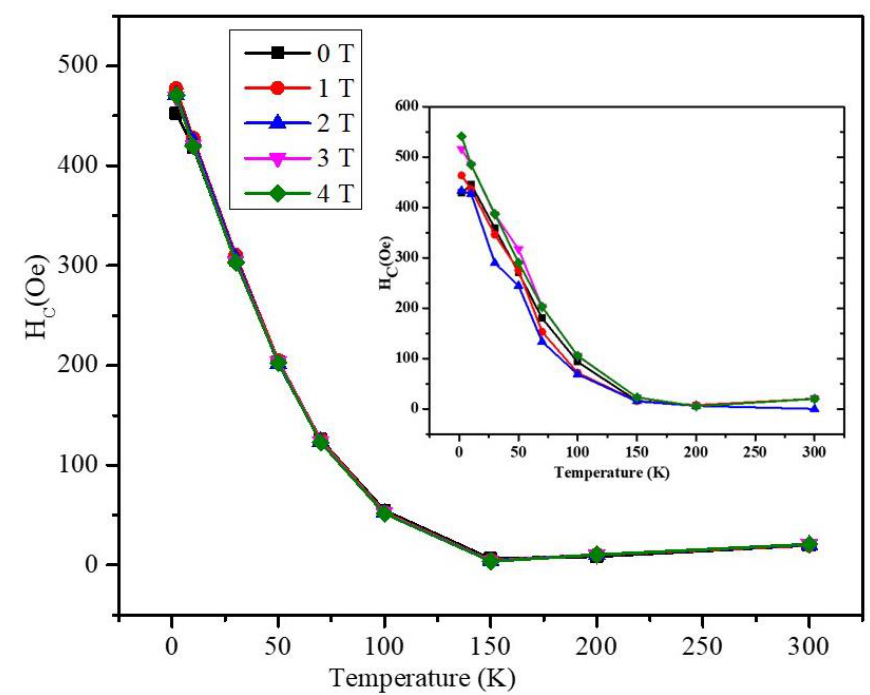
Figure 5. Temperature-dependent coercivity of the maghemite nanoparticles under field cooling of 0, 1, 2, 3, and 4 T (The inset is the coercivity as a function of temperature for undoped maghemite nanoparticles).